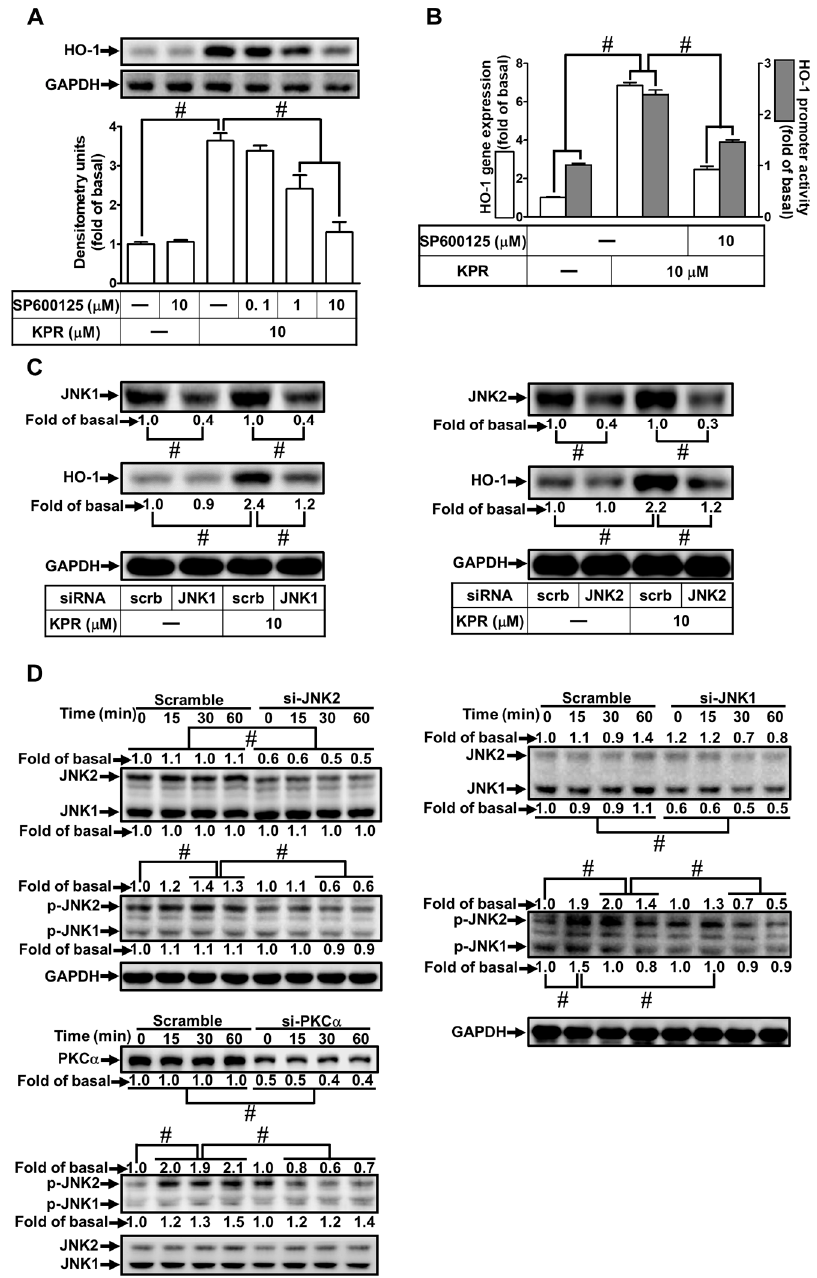
Figure 9. JNK1/2 is necessary for KPR-induced HO-1 expression. ( A ) HPAEpiCs were pretreated with various concentrations of SP600125 for 1 h and then incubated with DMSO or KPR (10 μ M) for 16 h. The protein expression of HO-1 was determined by Western blot using GAPDH as a loading control. ( B ) Cells were pretreated with/without SP600125 (10 µ M) for 1 h, and then incubated with DMSO or KPR (10 µ M) for 6 h or 8 h. The HO-1 mRNA expression and promoter activity were analyzed by real-time PCR (6 h) and promoter activity assay (8 h), respectively. ( C ) Cells were transfected with scrambled (scrb), JNK1, or JNK2 siRNA, and then incubated with KPR (10 µ M) for 16 h. The protein levels of HO-1, JNK1/2, and GAPDH were determined by Western blot. ( D ) Cells were transfected with PKC α , JNK1, or JNK2 siRNA, and then incubated with KPR (10 µ M) for the indicated time intervals. The levels of phospho-JNK1/2, total JNK1/2, and total PKC α were determined by Western blot. Data are expressed as mean ± SEM ( n = 5), analyzed with one way ANOVA and Dunnett’s post hoc test. # p < 0.01, as compared with the cells exposed to vehicle alone; or significantly different as